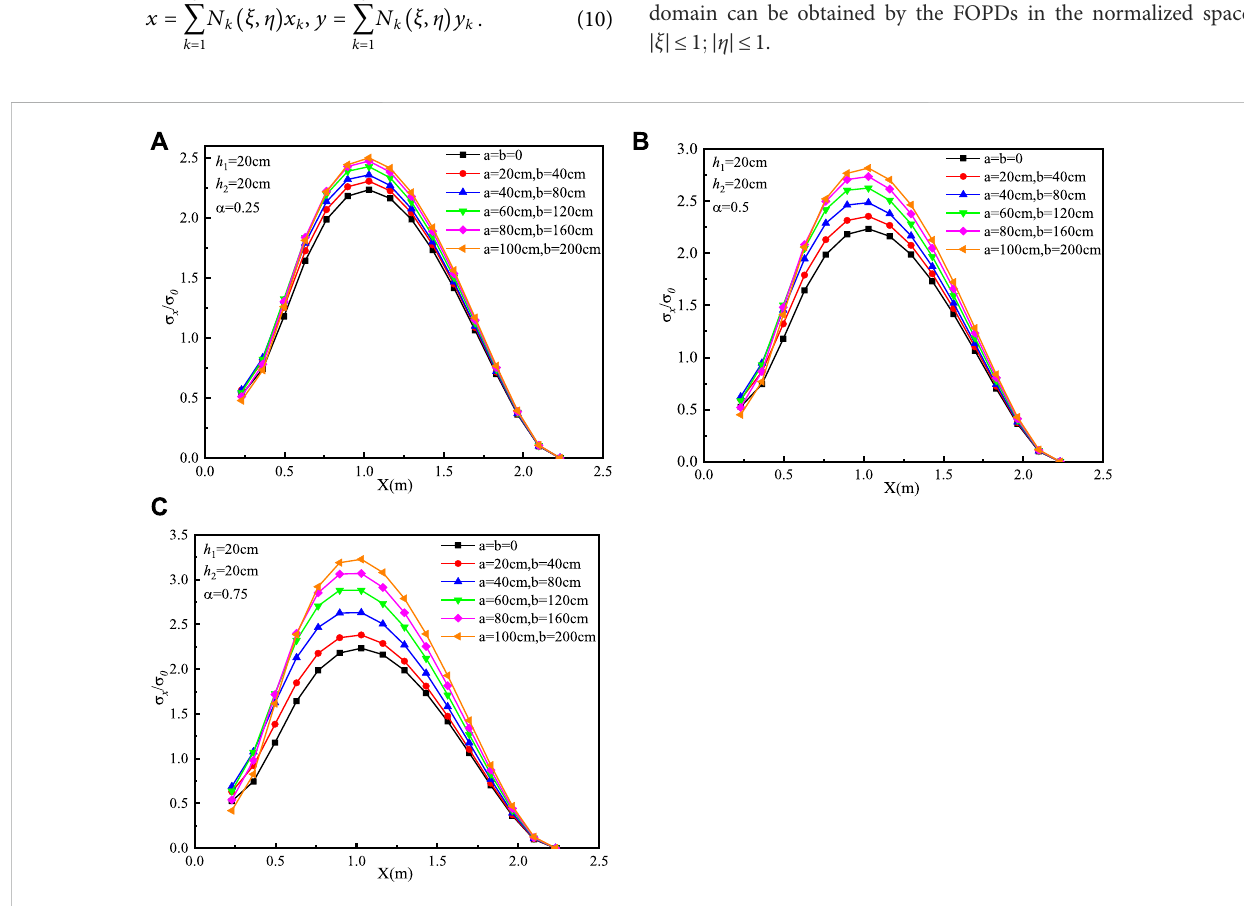
FIGURE 5 Dimensionless tensile stress distribution of the pavement using the MFBM with h 1 = h 2 = 20 cm: (A) α = 0.25, (B) α = 0.5, and (C) α =